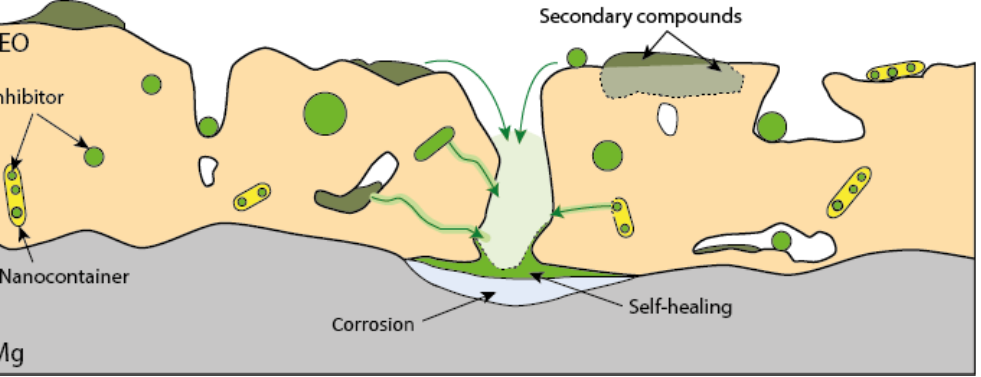
Figure 21. Schematic illustration of the corrosion protection mechanisms provided by PEO coating with